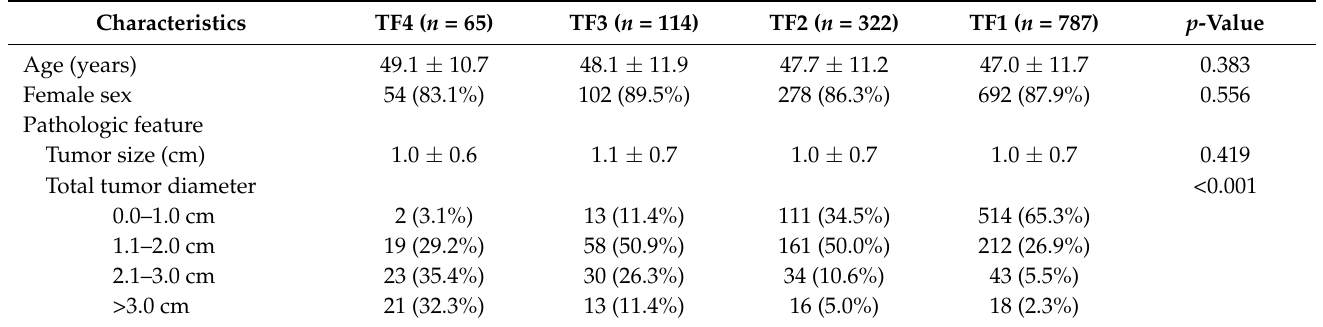
Table 2. Comparison of clinicopathological characteristics among patients with PTC according to the number of tumor